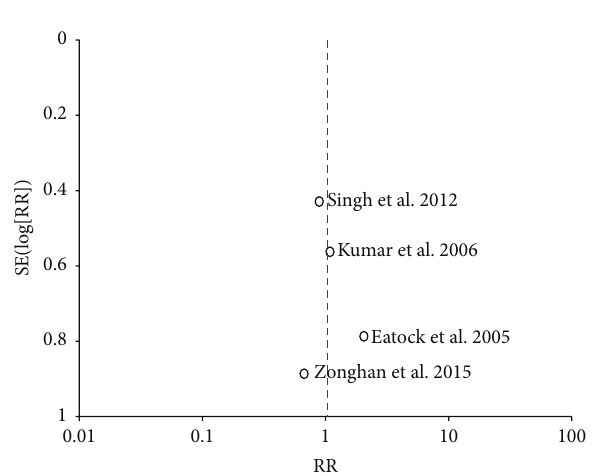
Figure 8: Funnel plot for publication bias.